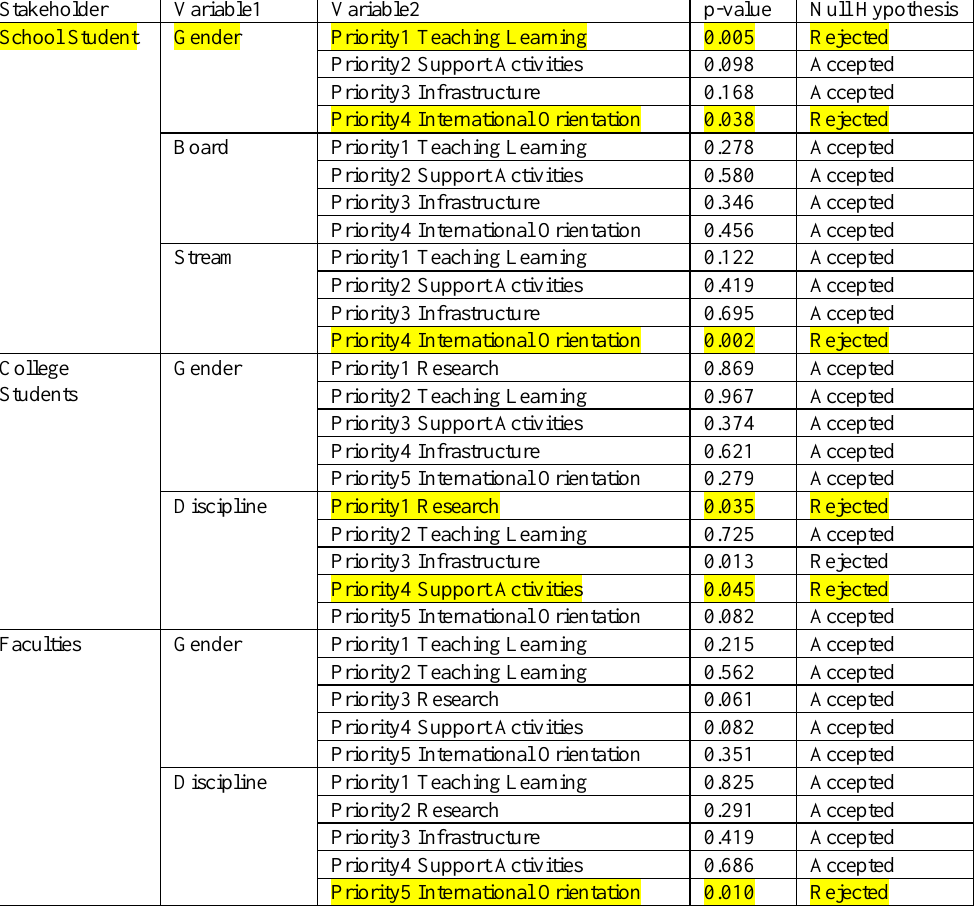
Table 3: chi-square test